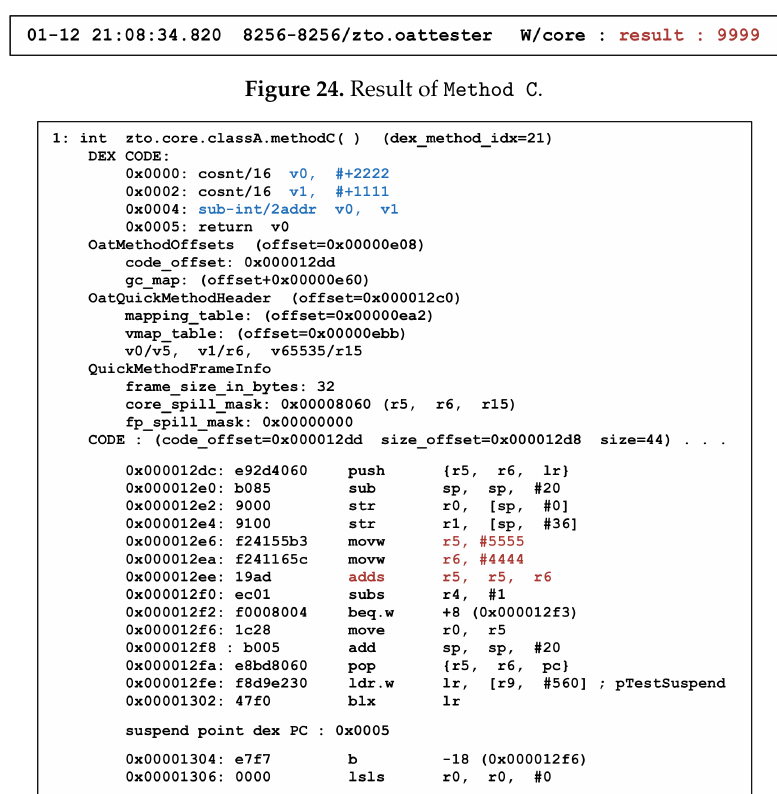
Figure 25. Dump Method C in Core OAT